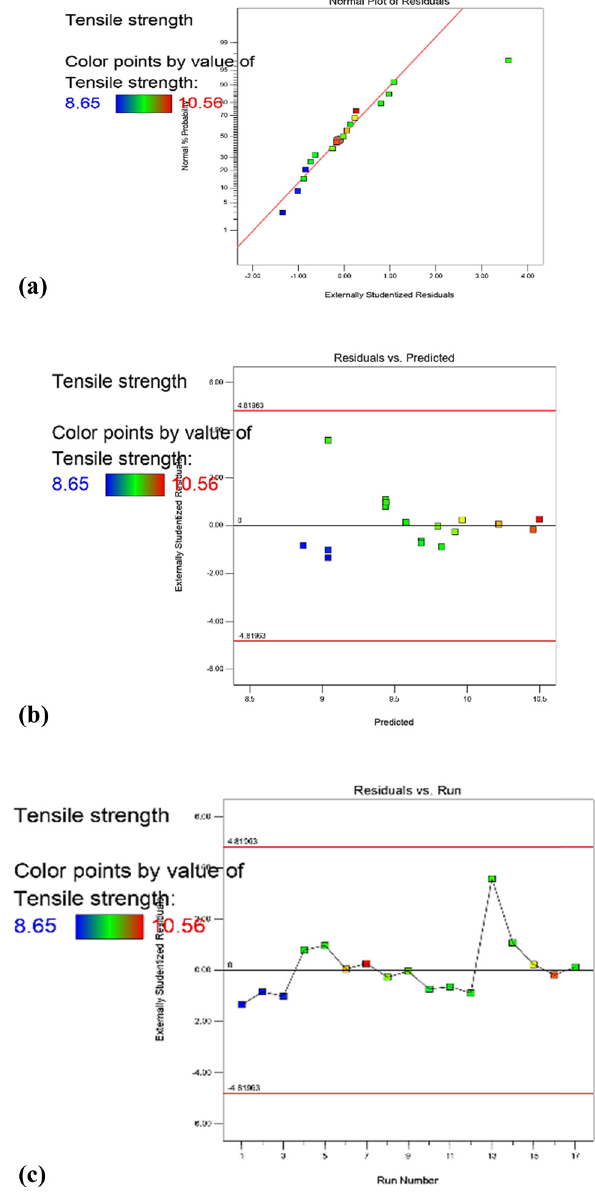
Figure 12: ( a ) Normal percent probability graph for tensile strength. ( b ) Residual vs predicted graph for tensile strength. ( c ) Residual vs run graph for tensile